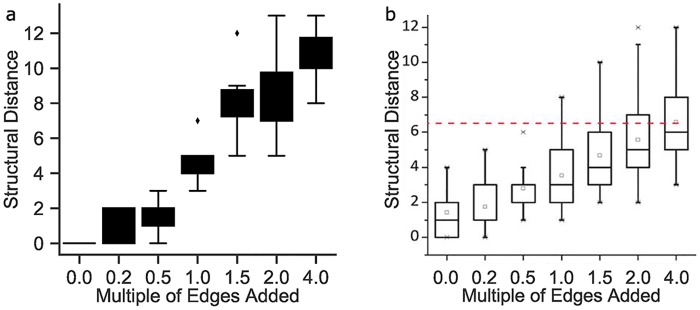
Performance and robustness of BONITA-RD.(a) Boxplots show minimum structural distance among the equivalent rule sets learned by BONITA-RD (y-axis) or (b) structural distance among rules learned by Liu’s method across prior knowledge network [9]. Structural distance is measured as the number of edges that must be added or removed after optimization to obtain the original correct network for addition of false positive edges 0, 0.2, 0.5, 1, 1.5, 2, or 4 times the edge number (x-axis). b) is reproduced from Liu et al. [9] and x-axis labels modified for ease of interpretation.